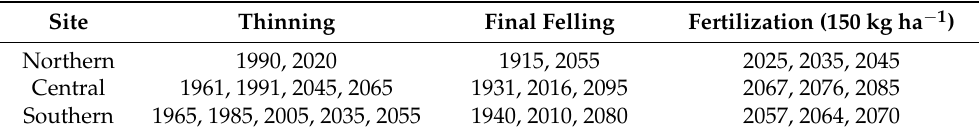
Table 4. Fertilization